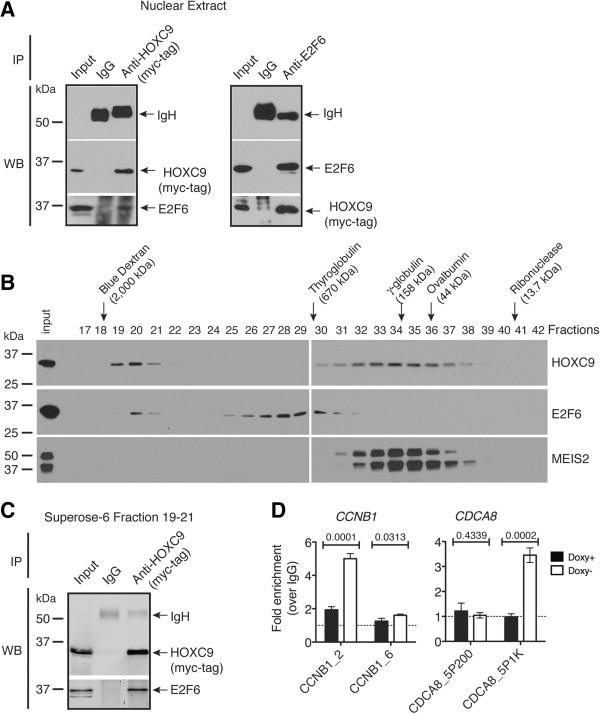
HOXC9 interacts with E2F6 and recruits it to cell cycle genes. (A) Reciprocal Co-IP of myc-HOXC9 and E2F6 in nuclear extracts from BE(2)-C/Tet-Off/myc-HOXC9 cells cultured in the absence of doxycycline (Doxy) for 6 days. (B) Size-exclusion chromatography analysis of complexes containing myc-HOXC9, E2F6 or MEIS2 in nuclear extracts of BE(2)-C/Tet-Off/myc-HOXC9 cells cultured in the absence of Doxy for 6 days. (C) Co-IP of myc-HOXC9 and E2F6 in pooled Superose-6 fractions 19–21. (D) ChIP-qPCR analysis showing E2F6 binding to specific promoter regions of the cell cycle genes CCNB1 and CDCA8 in BE(2)-C/Tet-Off/myc-HOXC9 cells before (Doxy+) and after (Doxy-) HOXC9 induction. Dashed lines indicate IgG control. Error bars represent SD (n = 3). Data were analyzed with unpaired, two-tailed Student’s t-test and p values are indicated.